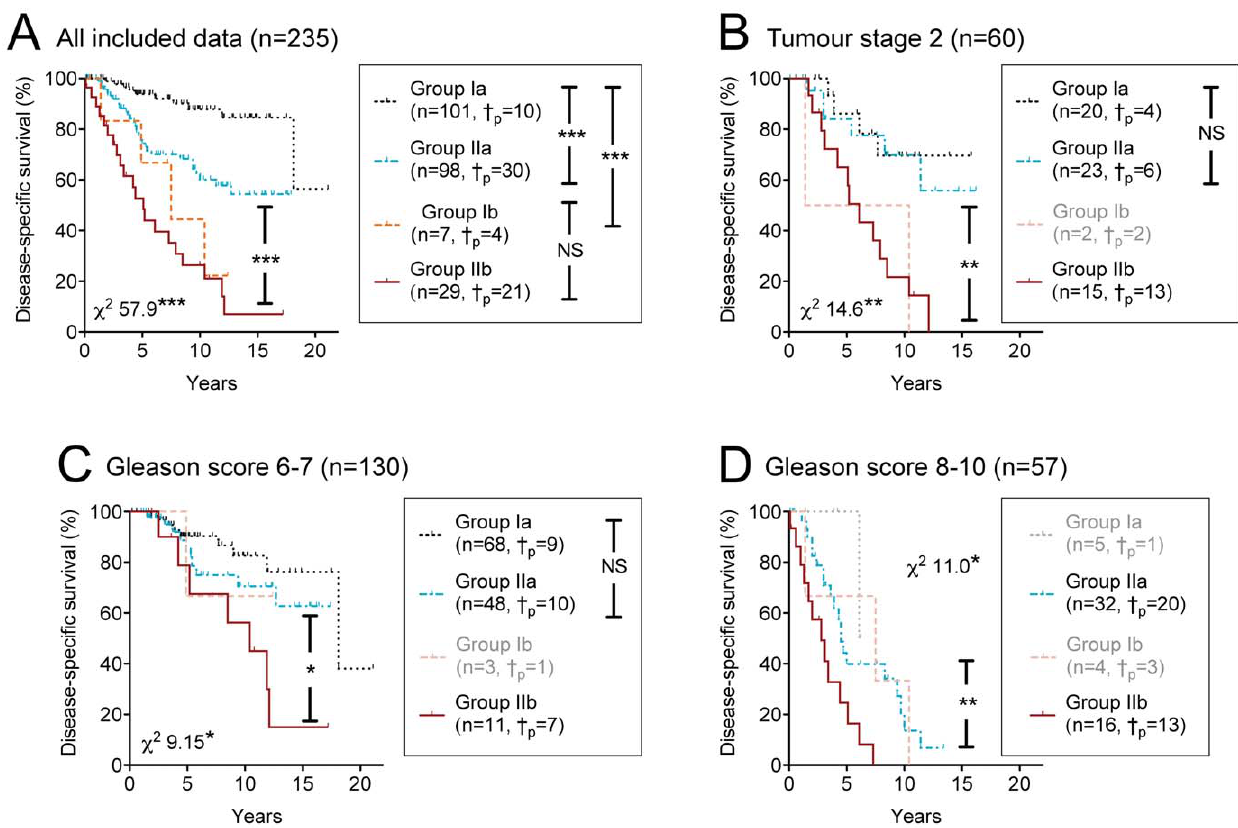
Figure 3. The influence of pEGFR-IR and CB 1 IR scores upon disease-specific survival of patients with prostate cancer. Panel A, all cases; B, cases with tumour stage 2; C, cases with Gleason scores of 6 or 7; D, cases with Gleason scores of 8–10. Scores are shown as CB 1 IR/pEGFR Group Ia (pEGFR-IR , 3.2, CB 1 IR , 2.3), Group IIa (pEGFR $ 3.2, CB 1 IR , 2.3), Group Ib (pEGFR-IR , 3.2, CB 1 IR $ 2.3) and Group IIb (pEGFR $ 3.2, CB 1 IR $ 2.3). { p refers to the number of cases who died as a result of the prostate cancer. The x 2 values shown in the panels are from the log rank (Cox- Mantel) test. Individual comparisons between two groups were also undertaken. The symbols given between the capped line in the figure itself indicate a comparison (log rank (Cox-Mantel) test) for Group IIa vs. Group IIb (i.e. between the blue and dark red survival curves), whilst the symbols between the capped lines in the legends indicate significance levels for the comparisons shown. When the group size was # 5, the curves are shown in a lighter colour, and whilst the data were included in the total x 2 statistic (bottom left in Panels A–C, top right in Panel D), individual comparisoms were not undertaken. ***p , 0.001, **p , 0.01, *p , 0.05, NS p . 0.2. In no case were the median pEGFR-IR scores in the Groups IIa and IIb significantly different from each other (p . 0.4, Mann-Whitney U-test).